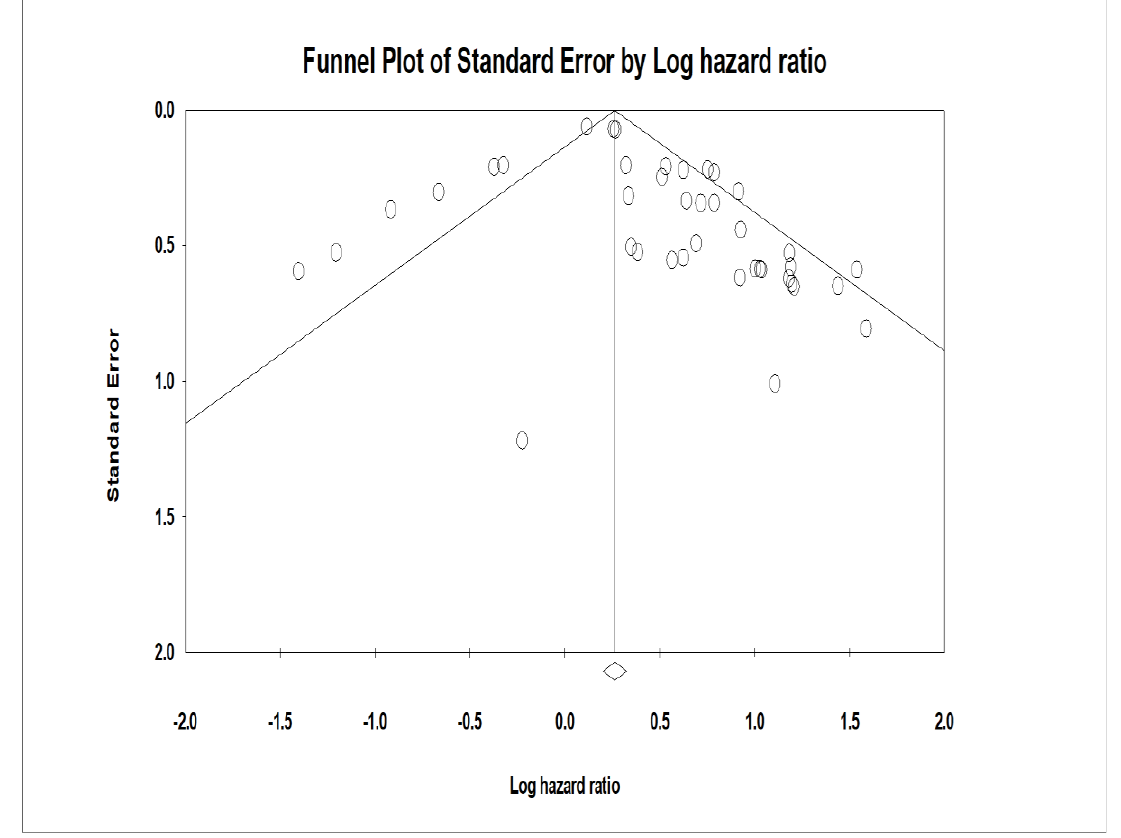
Figure 5. Funnel plot of the studies included in this comprehensive meta-analysis of miRNA.. Funnel plot with inputted studies (studies included in this comprehensive meta-analysis of miRNA-specific chemoresistance in head and neck cancer). The black circles indicate imputed